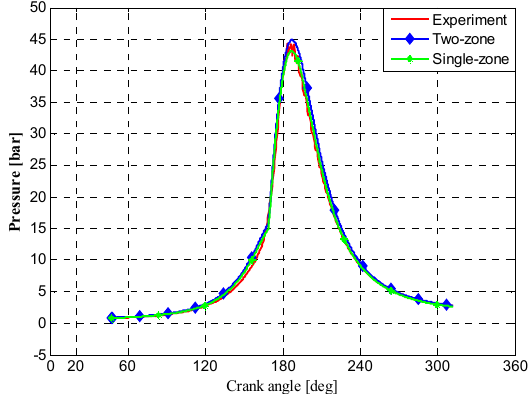
Figure 7. In-cylinder pressure comparison.